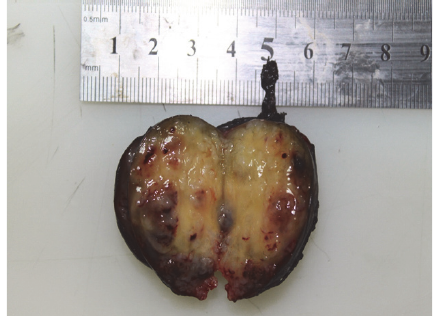
Figure 1: A 32 × 40 mm homogeneous mass (white arrow) in the left adrenal region showing a regular contour on computed tomography.